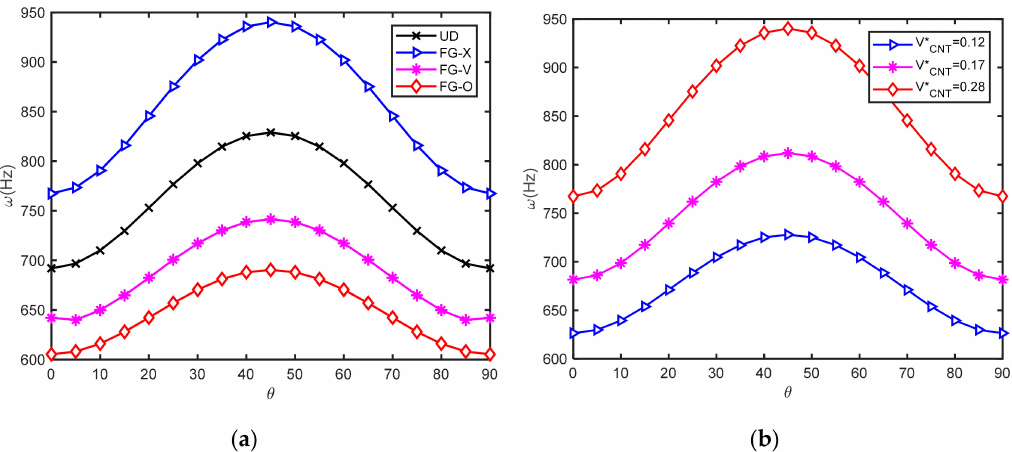
Figure 2. E ff ect of lamination angle on the natural frequency of laminated functionally graded carbon nanotube-reinforced composite plates (FG-CNTRC) plate coupled with O-circuit piezoelectric layer: ( a ) for di ff erent carbon nanotube (CNT) distribution types; ( b ) for di ff erent CNT volume